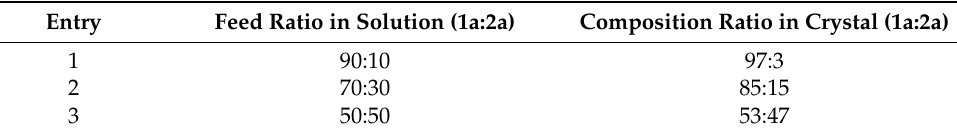
Table 2. Feed ratio of 1a and 2a in solution and composition ratio of 1a and 2a in two-component mixed crystals, which was determined by HPLC. The mixed crystals were prepared by recrystalliza- tion from acetone.